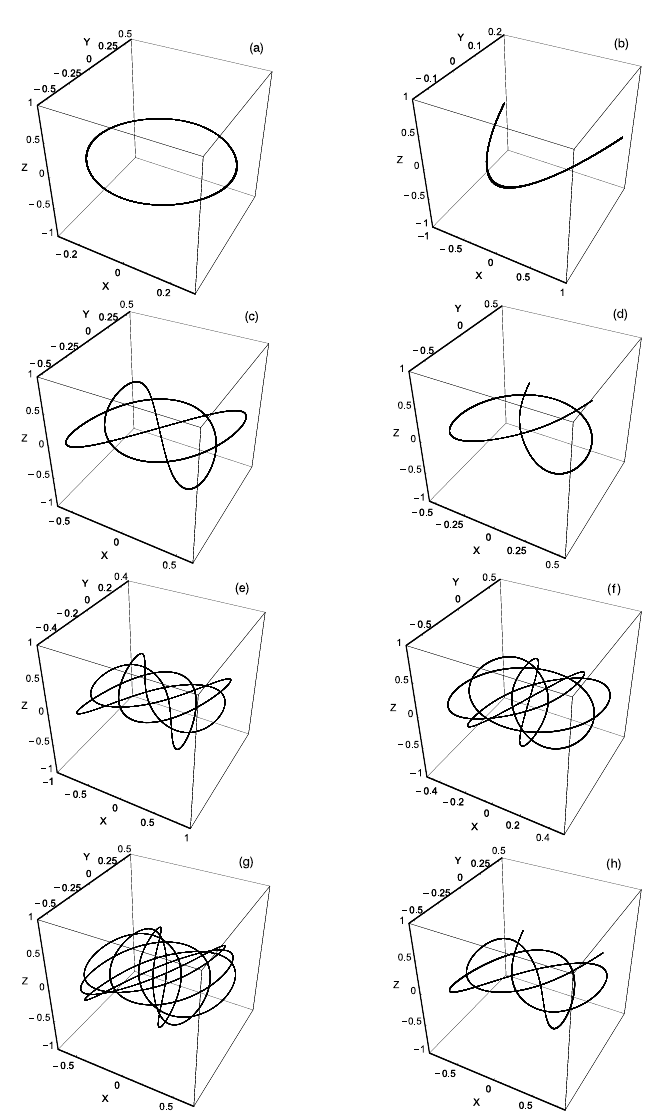
Fig. 12. Panels (a)–(h): representative periodic orbits in the 3D dynamical system. See the text for details. (2D) revealed a large variety of resonant orbits, different chaotic components and several sticky regions. The different chaotic components of the 2D system do not merge to produce a unified chaotic region, even for time intervals much larger than the age of the